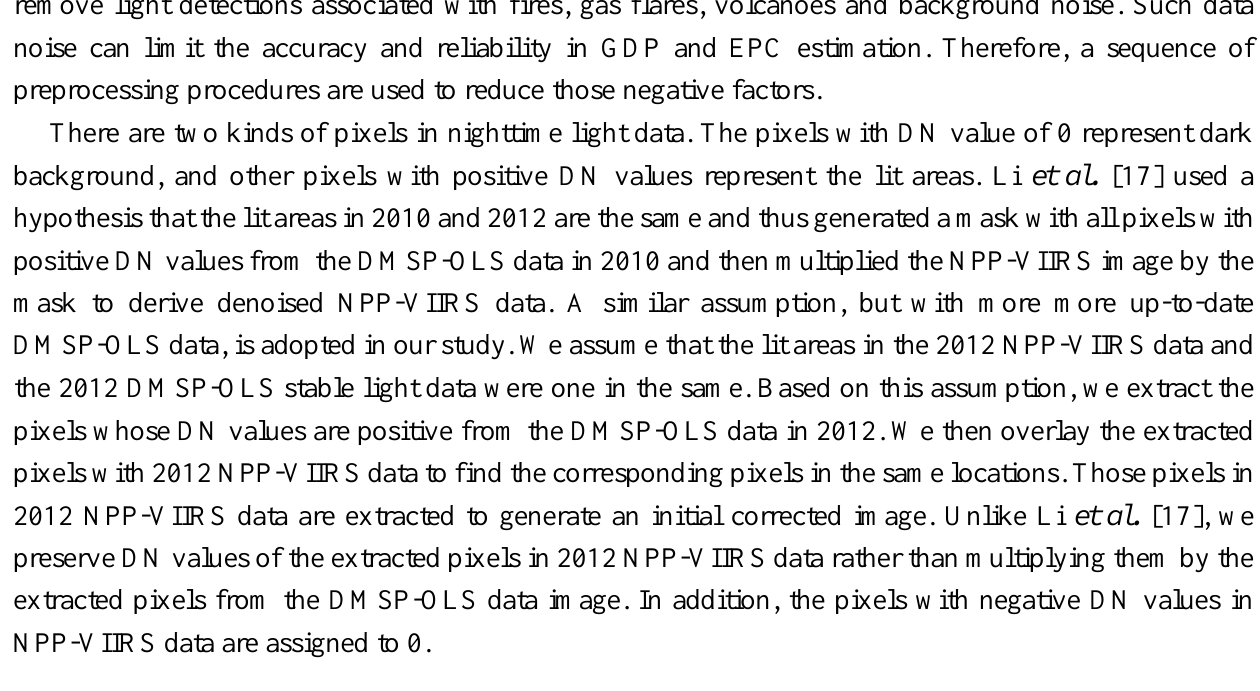
Figure 3. The original nighttime light data of Beijing, Guangzhou, and Shanghai in